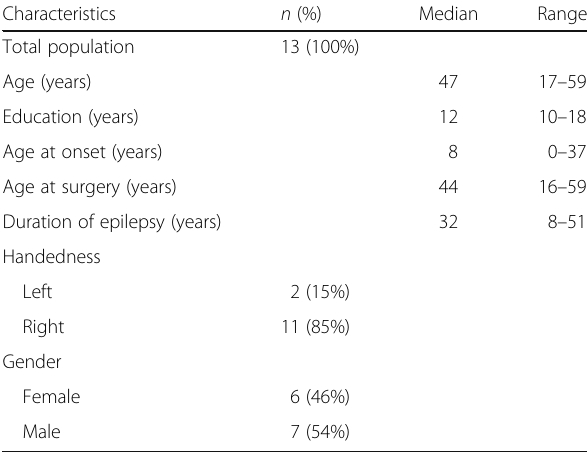
Table 1 Demographic variables of patients with left MTLE-HS